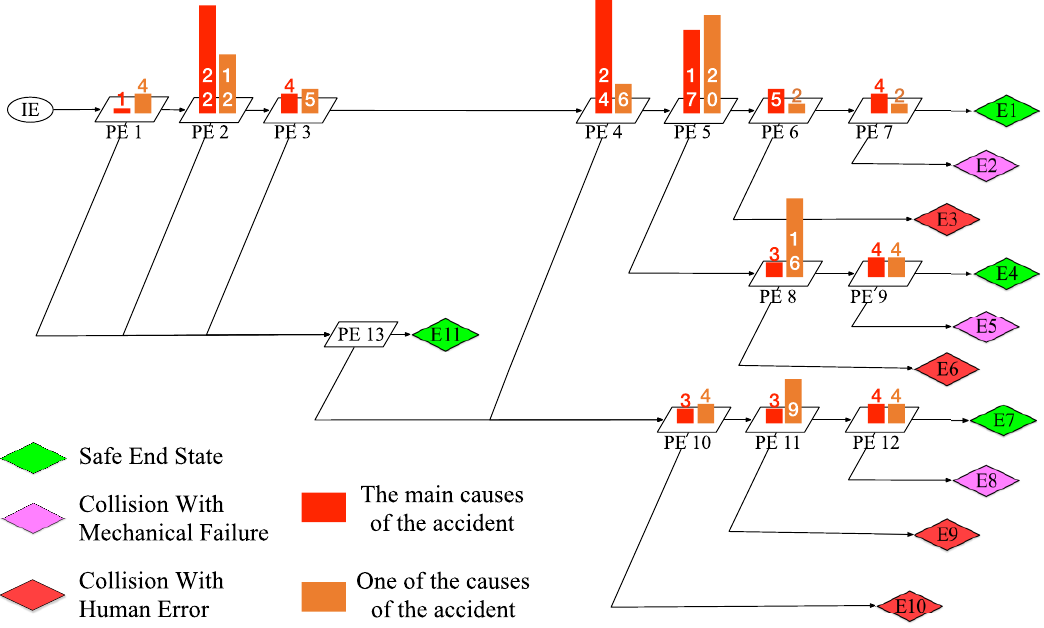
Figure 4. Statistics of accidents based on accident event sequence logical.